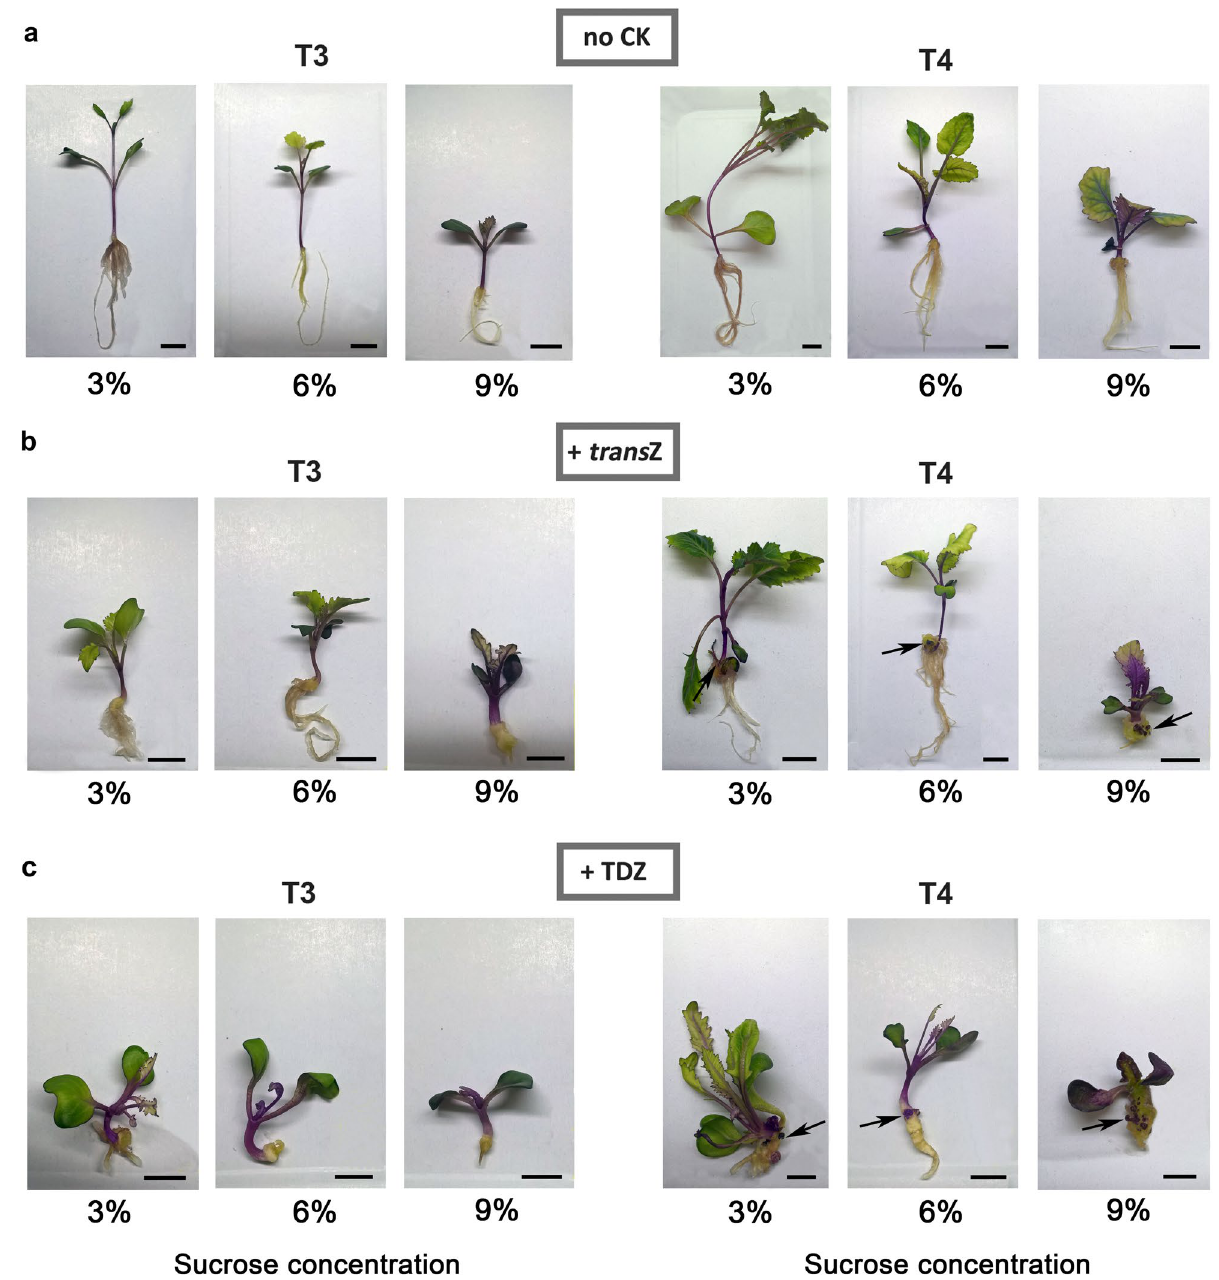
Figure 1. Callus formation (T3) and de novo shoots regeneration (T4) during de novo shoot organogenesis ( arrow ) of kohlrabi (cv. Vienna Purple) on media containing 3/6/9% sucrose without the presence of cytokinins ( a ), with 2 mg L −1 trans Z ( b ) or with 2 mg L −1 TDZ ( c ). Size bar = 1 cm. trans Z: trans -zeatin; TDZ: